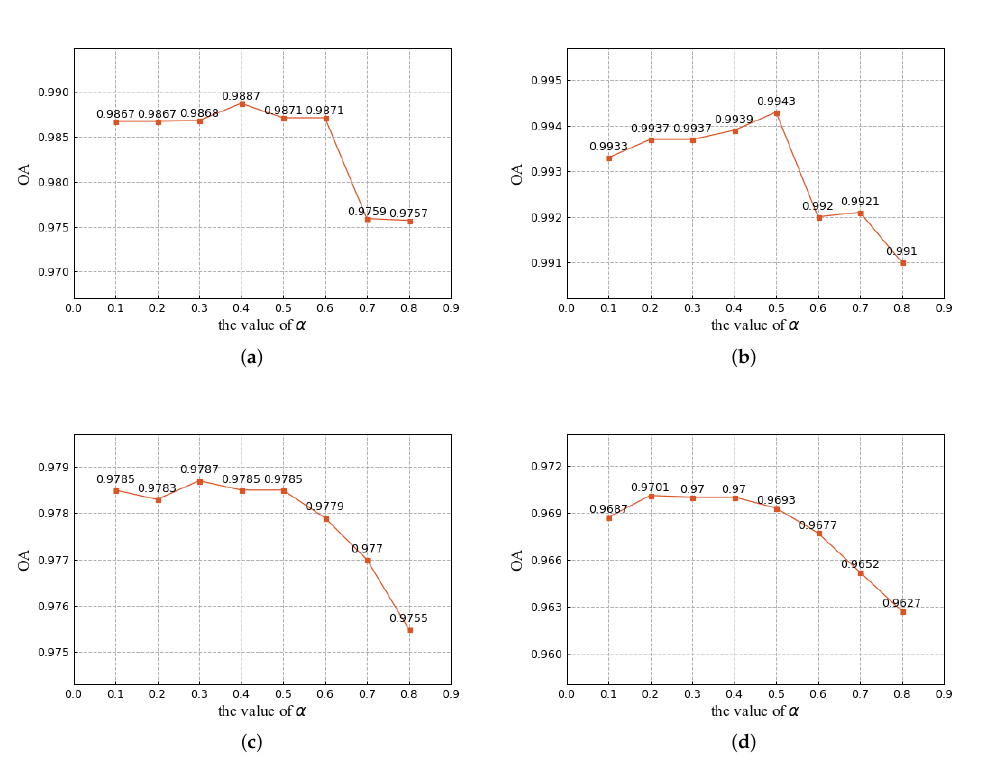
Figure 13. Analysis of the momentum parameter α . ( a ) Bastrop dataset. ( b ) Umatilla dataset. ( c ) Yancheng dataset. ( d ) River dataset.